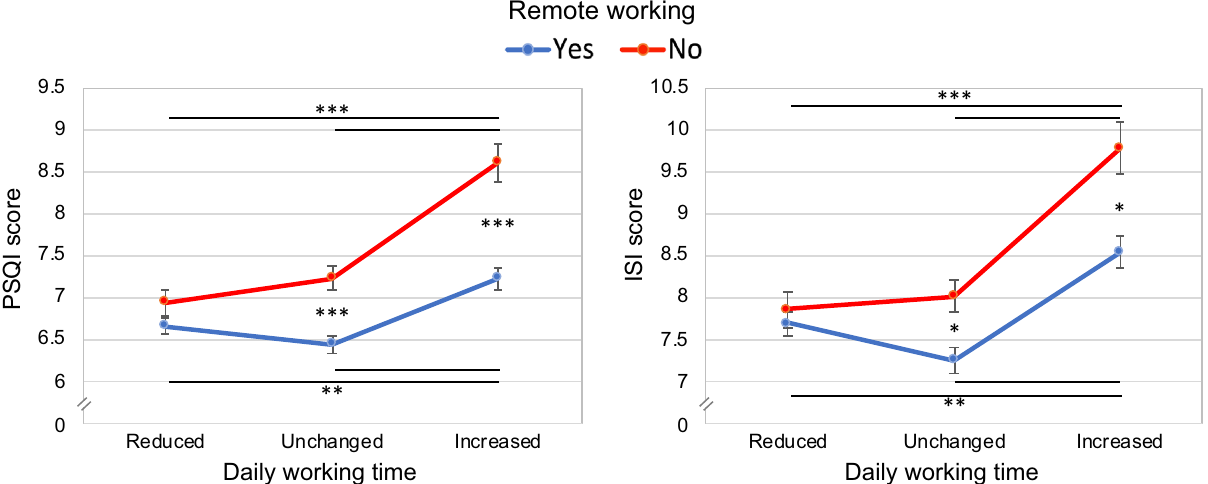
Figure 2. Interaction between "remote working" (yes, no) and "daily working time" (reduced, unchanged, increased) factors, for sleep quality (PSQI) and insomnia severity symptoms scores (ISI). The figures report means (and standard errors) of the scores of the PSQI and ISI questionnaires. Results of Bonferroni post hoc comparisons are reported with asterisks (* p < 0.05; ** p < 0.01 *** p <